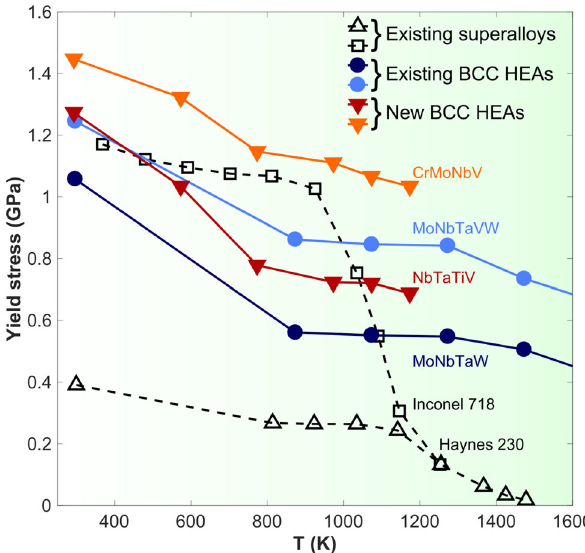
Fig. 1 Alloy strength vs . temperature. The refractory BCC HEAs retain high strengths up to temperatures well beyond those where superalloys lose strengths. The NbTaTiV alloy here is comparable to the literature MoNbTaVW and MoNbTaW alloys. The strength of the CrMoNbV alloy, predicted to be even stronger, signi fi cantly exceeds the strengths of the existing BCC HEAs. The strengths of NbTaTiV and CrMoNbV are found here to be controlled by edge dislocations — see Figs. 2, 3, and 4 — not screw dislocations. Literature data are reproduced from ref. 8